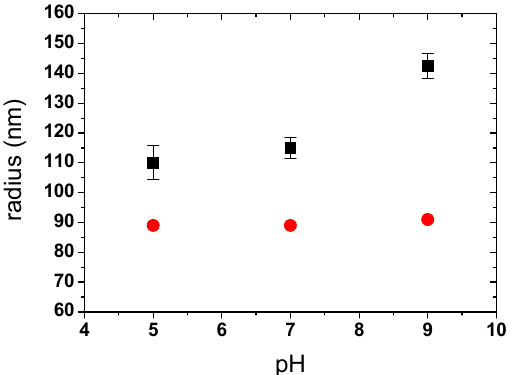
Figure 6. Effect of pH on the radius of PAA-PAH double-layer modified SPBs measured by DLS and SAXS (C NaCl = 10 mM). Symbols denote: ( ■ , black) DLS, ( ● , red) SAXS.